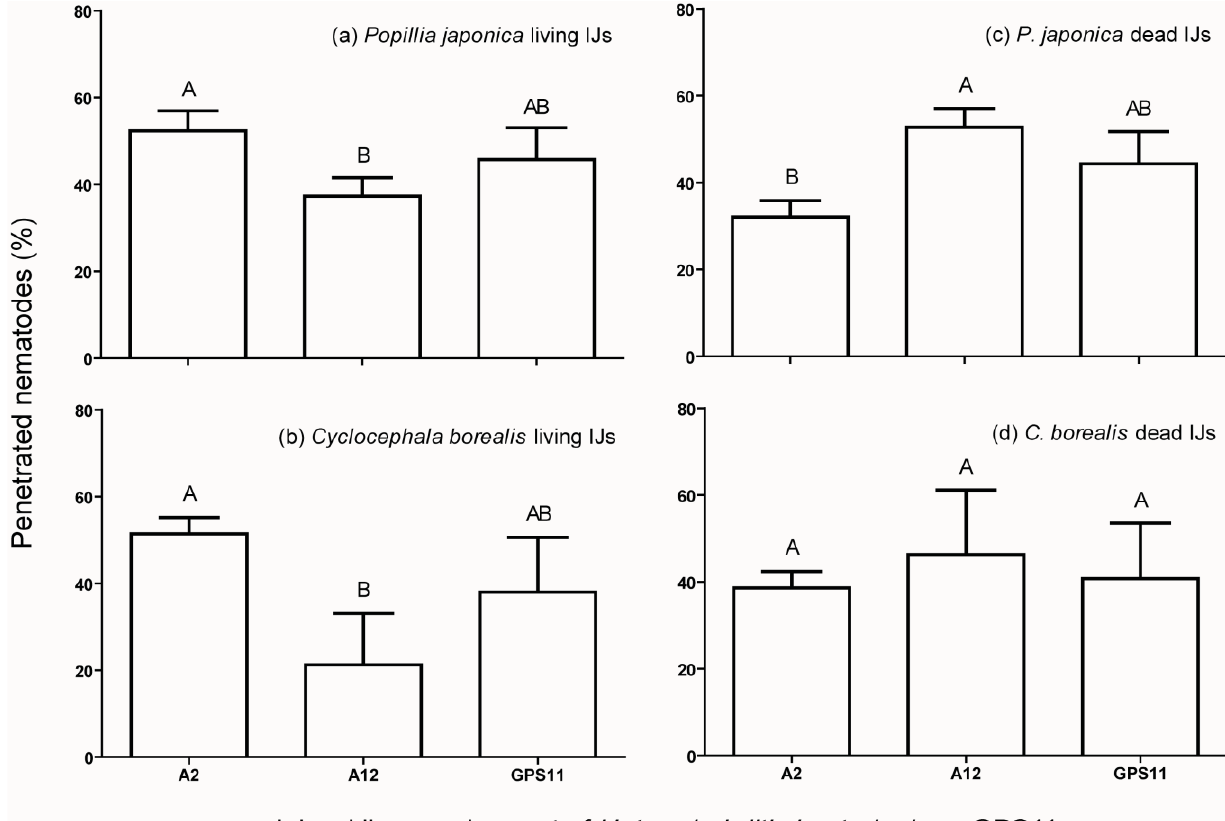
Figure 2. Mean percentage of live and dead infective juveniles of inbred lines, A2 and A12 and parent GPS11 strain of Heterorhabditis bacteriophora found in Popillia japonica and Cyclocephala borealis grubs 24 h after incubation. Bars (mean ± SEM) with same letter(s) are not significantly different according to P < 0.05 (Tukey’s HSD test)